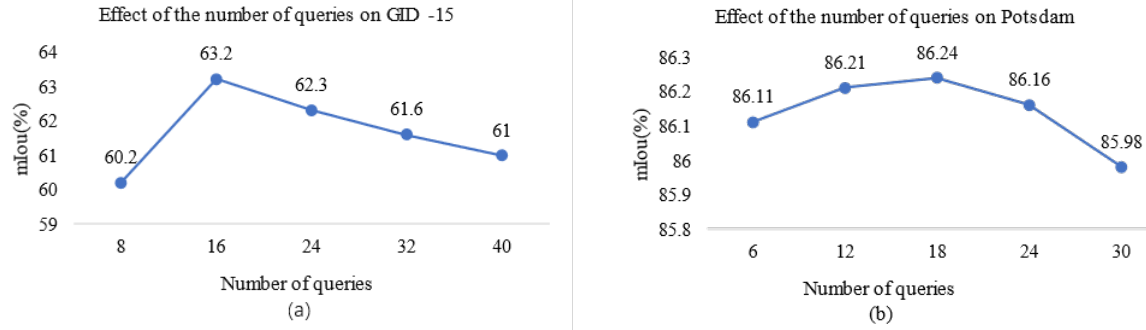
Figure 7. Ablation studies on the number of object embedding queries.